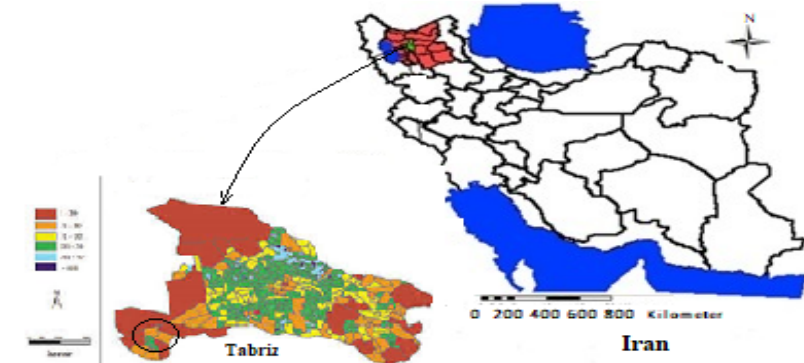
Fig.1: Geographic location of the study area in Tabriz urban environment in Iran